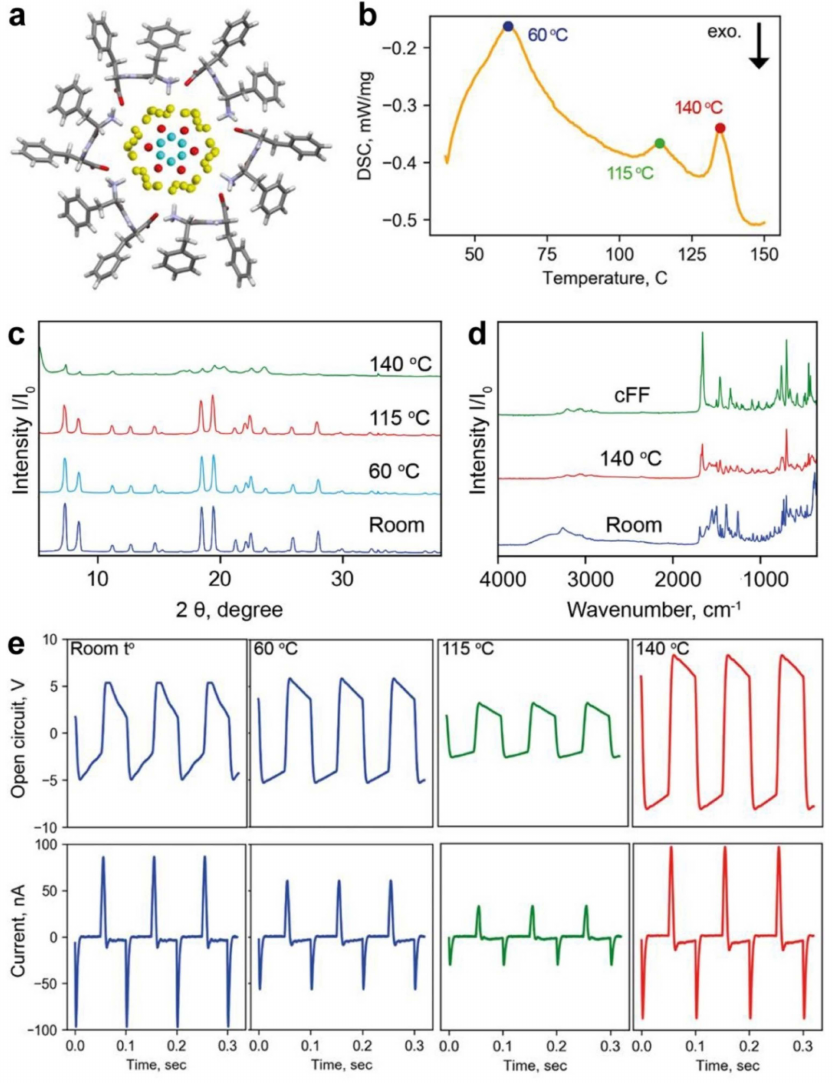
Figure 6. Layered structure of water molecules inside the FF nanochannels: ( a ) reconstruction of the FF nanotubes from X-ray data; yellow spheres denote bound water; red, and cyan